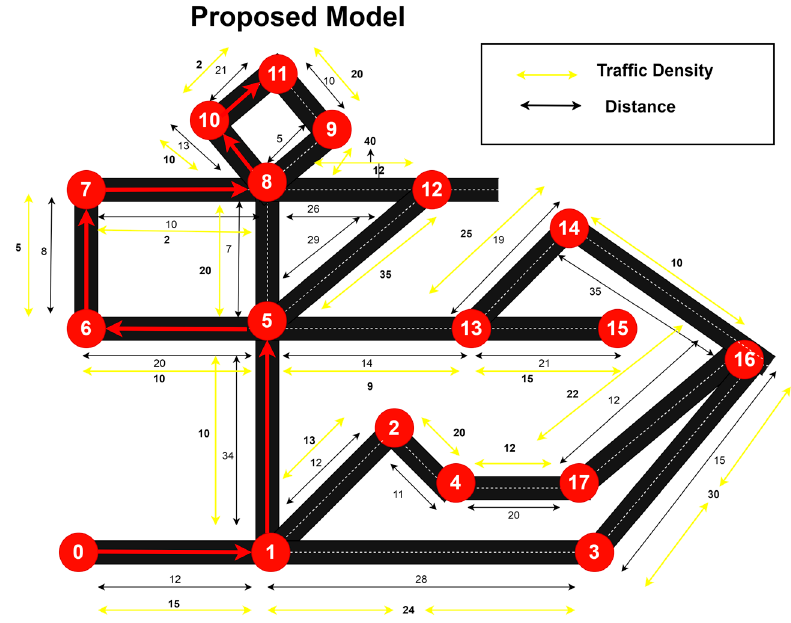
Figure 4. The shortest path derived from the proposed model.